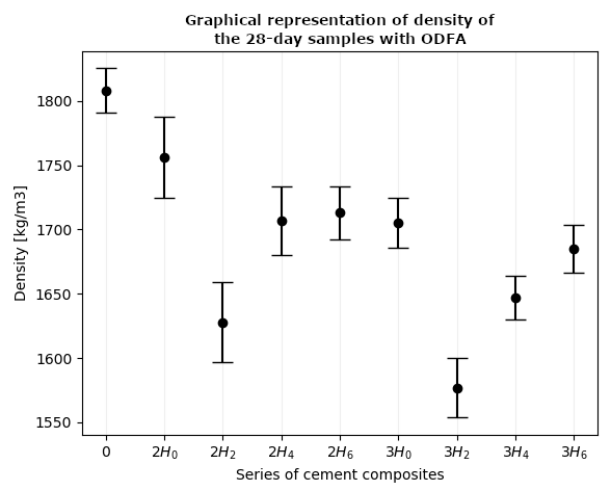
Figure 9. Density data of the 28-day series of composites.